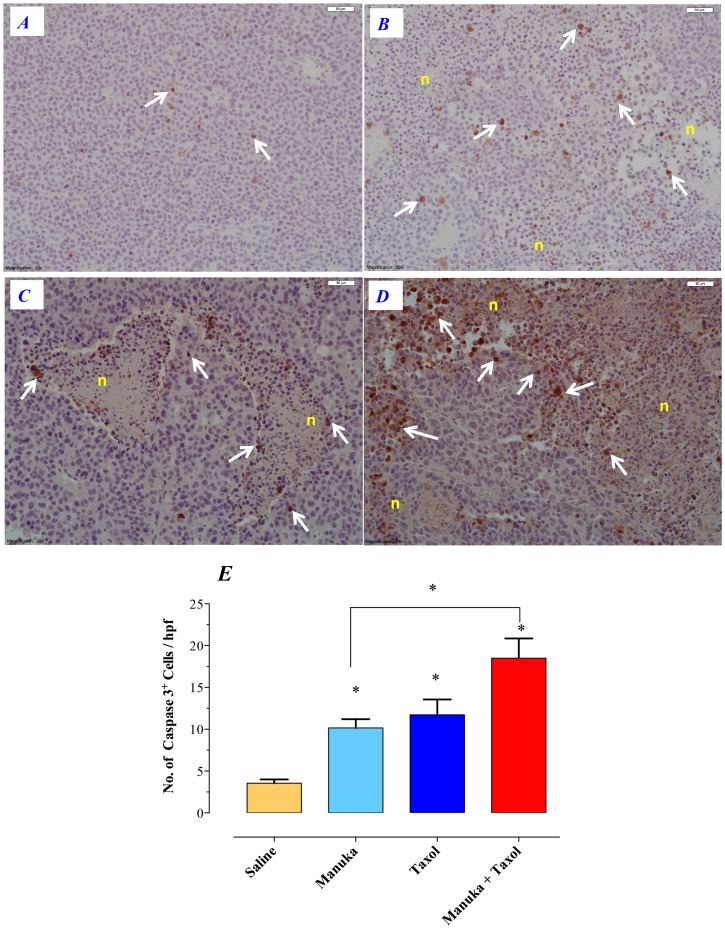
Immunohistochemical staining for intratumor caspase-3+ apoptotic cells.Tumor tissue sections were prepared after treatment with saline (panel A), manuka honey (panel B), taxol (panel C) or manuka+taxol (panel D) and stained using caspase 3-specific antibody, as described in Materials and Methods. Representative images at high magnification (bar = 50 µm) are shown. Arrows indicate representative, brown-staining, apoptotic cells. Necrotic regions are also indicated (n). The results are representative of two independent experiments. (E) Quantitative estimation of the number of caspase-3 positive cells in tumor sections of different treatment groups. The data is shown as the mean ± SEM of the number of positive cells per high power field. Tumors were obtained from 2–3 mice per treatment group and multiple sections were made from each tumor tissue. The number of positive cells was determined by counting the number of cells in 20 high power fields per section. Asterisks denote statistically significant differences between each experimental group and the saline control group; also shown is a comparison between manuka alone and manuka+taxol groups (*, p<0.05).